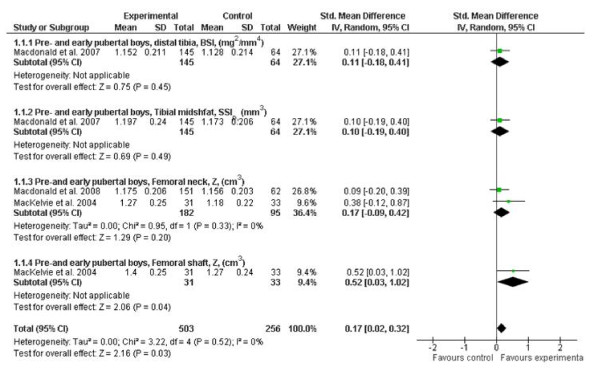
Effects of exercise on bone strength (standard mean difference, 95% CI) in young boys at the distal tibia, tibial shaft and femoral neck. The squares and diamonds represent the test values for individual studies and the overall effect, respectively.